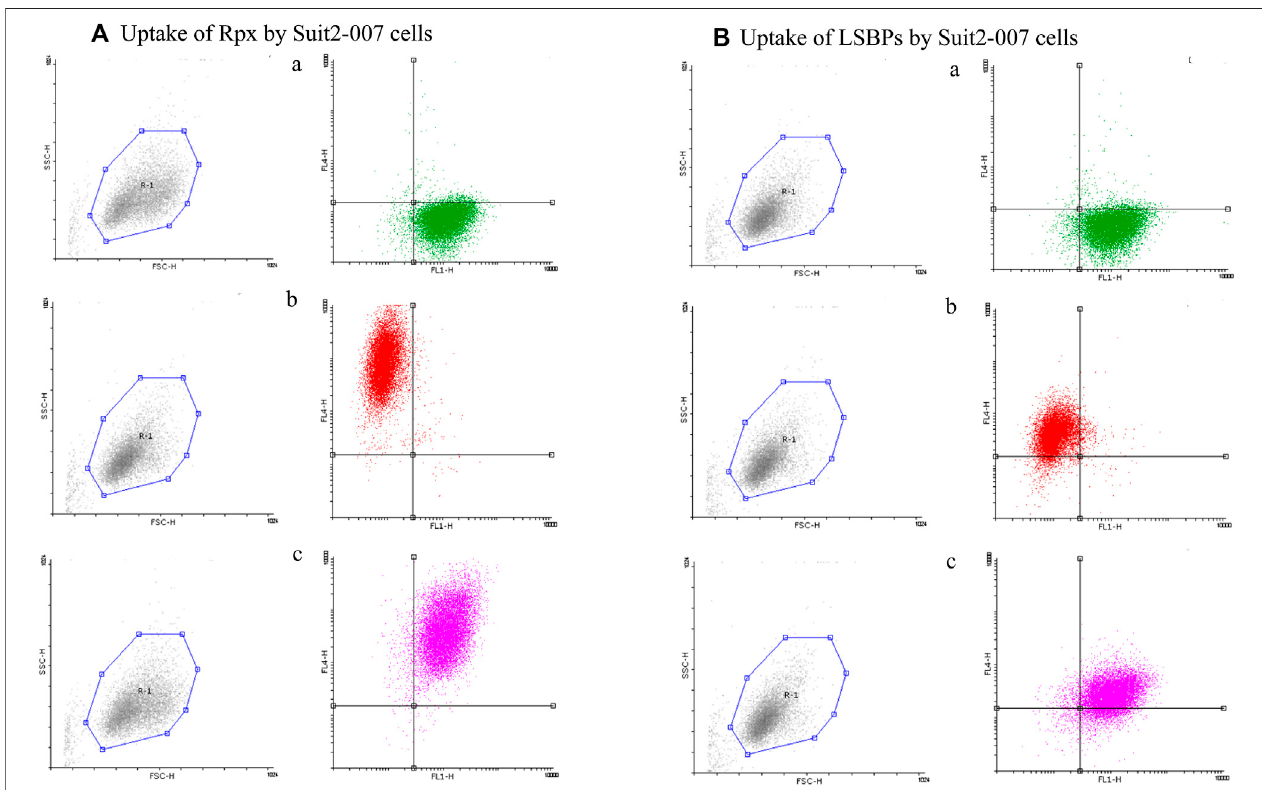
FIGURE 4 | Cellular uptake of riproximin and LSBPs by FACS. (A,B) Represents the FACS analysis of an uptake experiment, in which Suit2-007 cells had been exposed to riproximin or LSBPs. Both, riproximin and LSBPs had been labeled with the dye Alexa Fluor 647 and an antibody against EpCAM, labeled by the dye Alexa Fluor 488. (A) Shows Suit2-007 cells, which had been exposed to riproximin, and (B) those, which had been exposed to LSBPs. The corresponding letters a, b, and c are indicative of the antibody stained cells (green), Alexa Fluor labeled (red) riproximin or LSBPs, and a combination of the two colors,